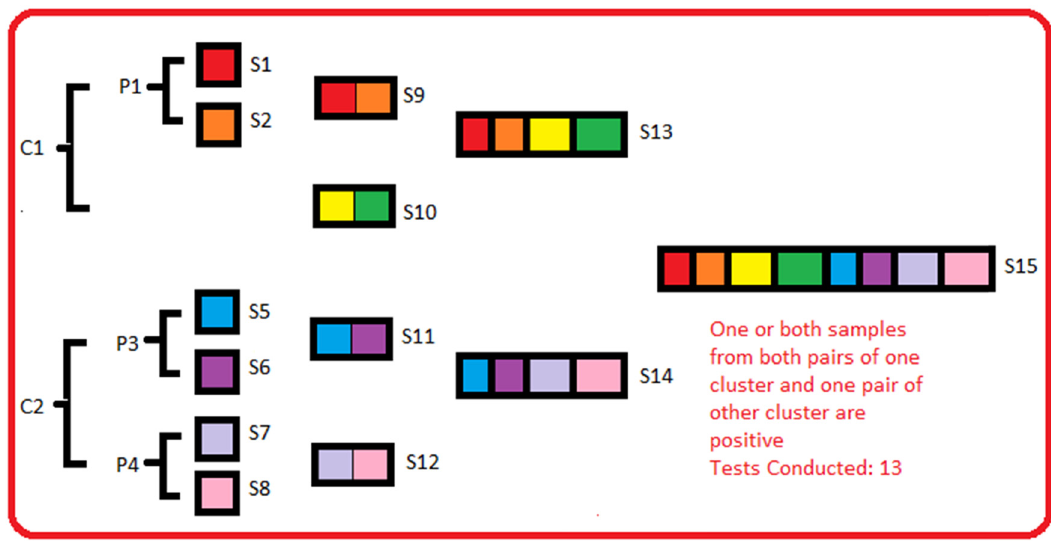
Figure 7: Thirteen tests to be performed to test eight